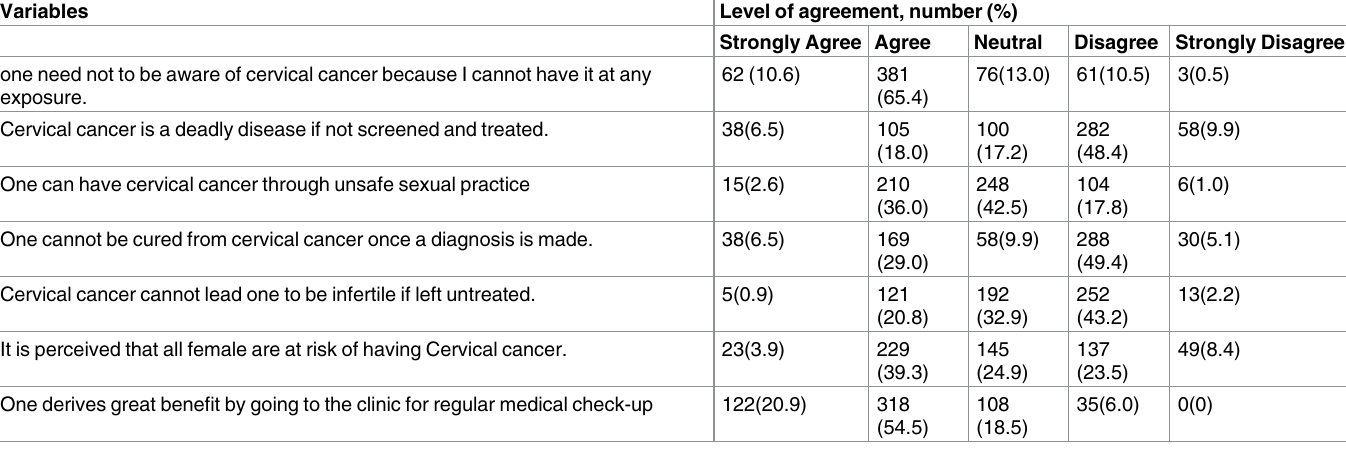
Table 3. Attitude of respondents about perceived susceptibility and severity,benefit of screening and prevention of cervicalcancer in Hossana town, Hadiya Zone, June 2015. Variables Level of agreement, number (%) Strongly Agree Agree Neutral Disagree Strongly